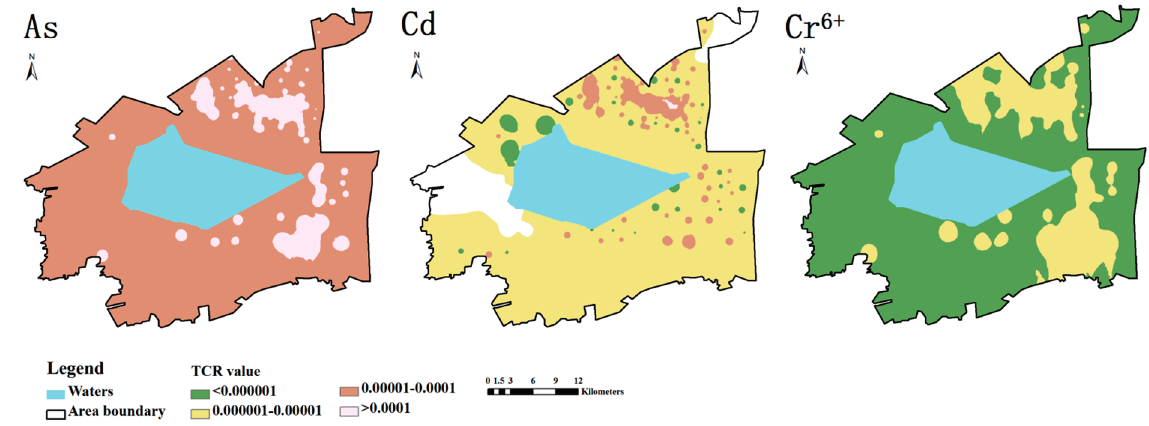
Figure 3. Spatial distribution map of the human health risks of three heavy metals posed by contaminated